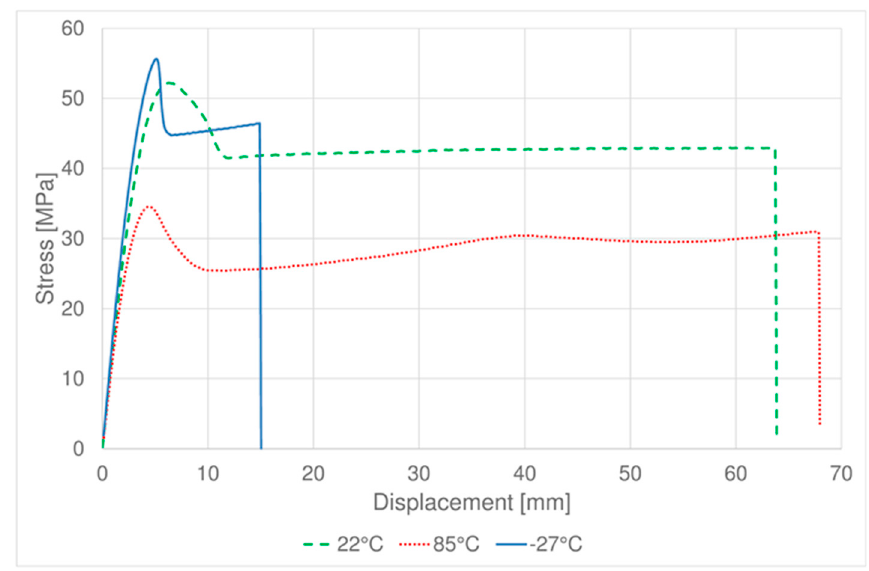
Figure 3. Tensile test of PC-ABS: average results at different temperatures.